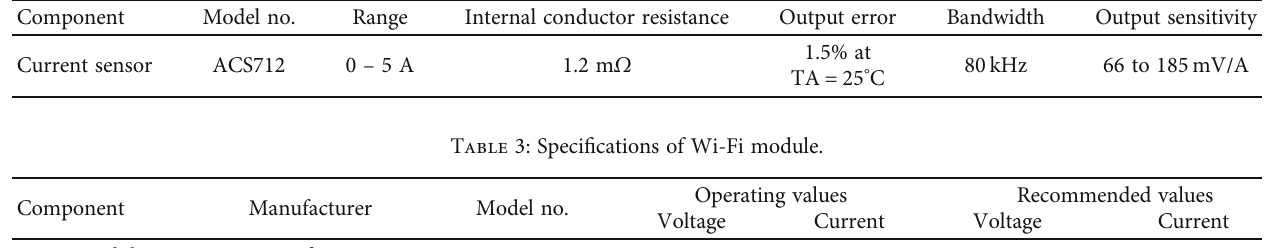
Table 2: Speci fi cations of current sensing device.